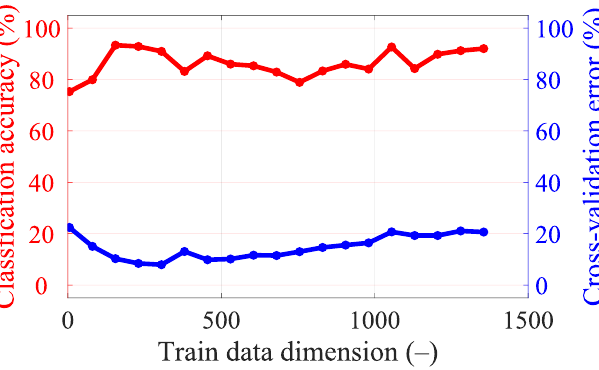
Figure A4. Classification accuracy and cross-validation error for different dimensionality reductions in data for 15 frequency points (from 0.8 GHz, step 0.05 GHz, to 1.5 GHz).